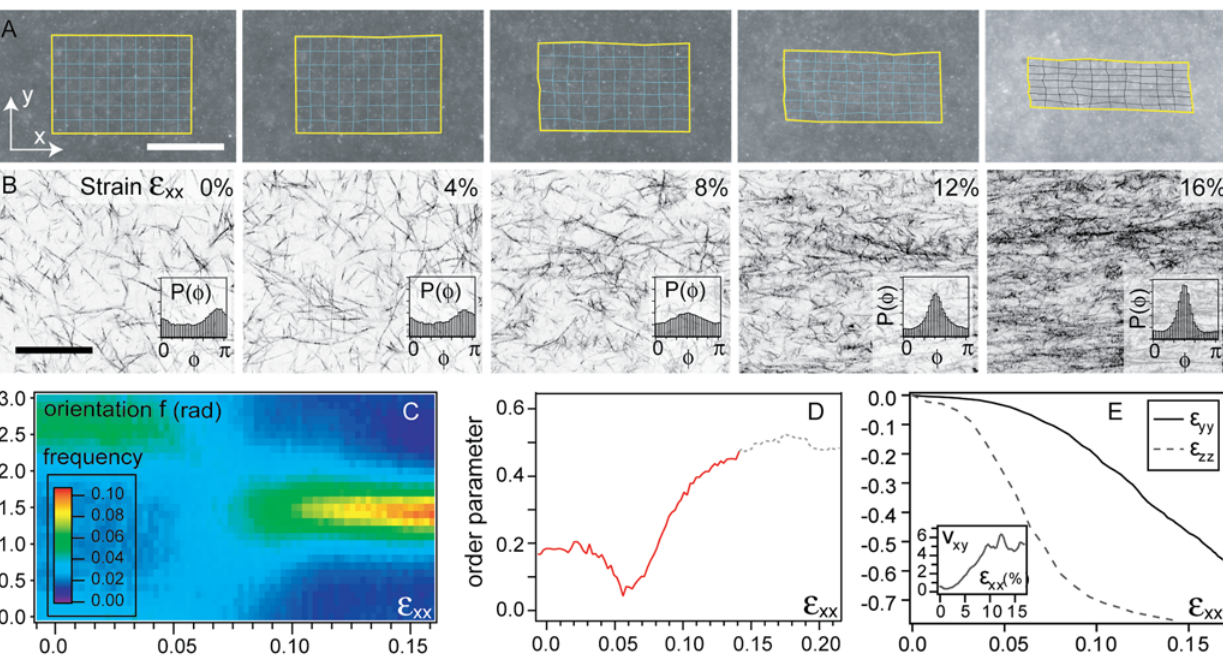
Figure 4. Typical results of a sample stretching experiment at micro- and meso-scale. The two montages of 5 images each show, for two different 1 mg/mL samples and at various strains, (A) wide-field fluorescence images of beads embedded within the network - the super-imposed grid is the result of the tracking of the deformation field (scale bar 500 m m); (B) direct imaging of the fibers through CRLSM (scale bar 50 m m). In inset, each corresponding w histogram, with angle values going from 0 to p . For the same samples depicted above: (C) represents the evolution of the orientation statistics; the color at each point corresponds to the relative count of fibers oriented along a specific direction at a given strain e xx . (D) shows the order parameter m resulting from the data in (C); the curve beyond 15% stretch is grayed out due to the lack of confidence of the order parameter when the high value of the density prevents a proper detection of the fibers (see Methods). (E) gives the deformations e yy and e zz as a function of the local strain e xx . In inset, the incremental Poisson ratio n xy as a function of the imposed